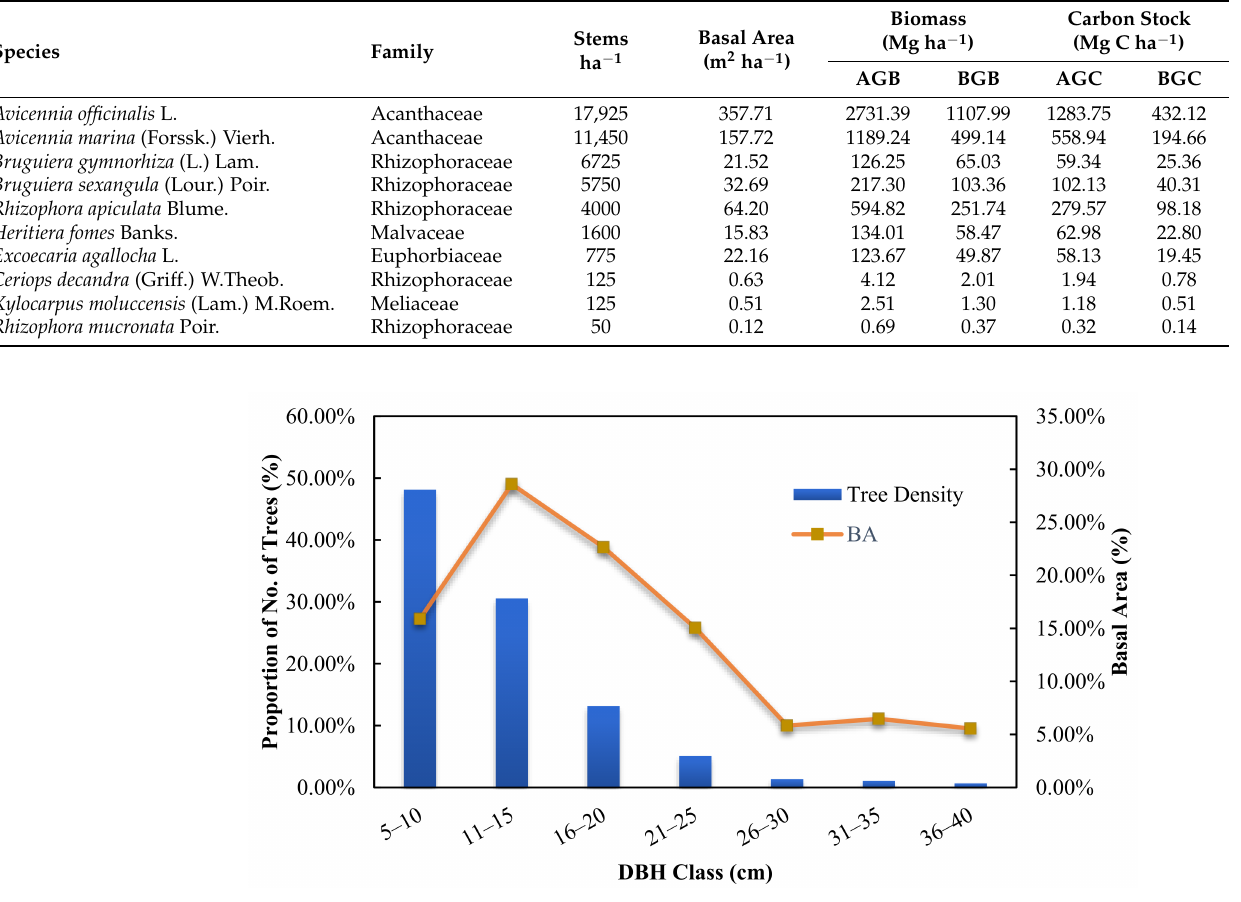
Figure 2. Diameter class distribution of tree density and basal area in the mangrove stand of the study site. Table 2. Distribution of stand structures, biomass, and carbon storage according to stand